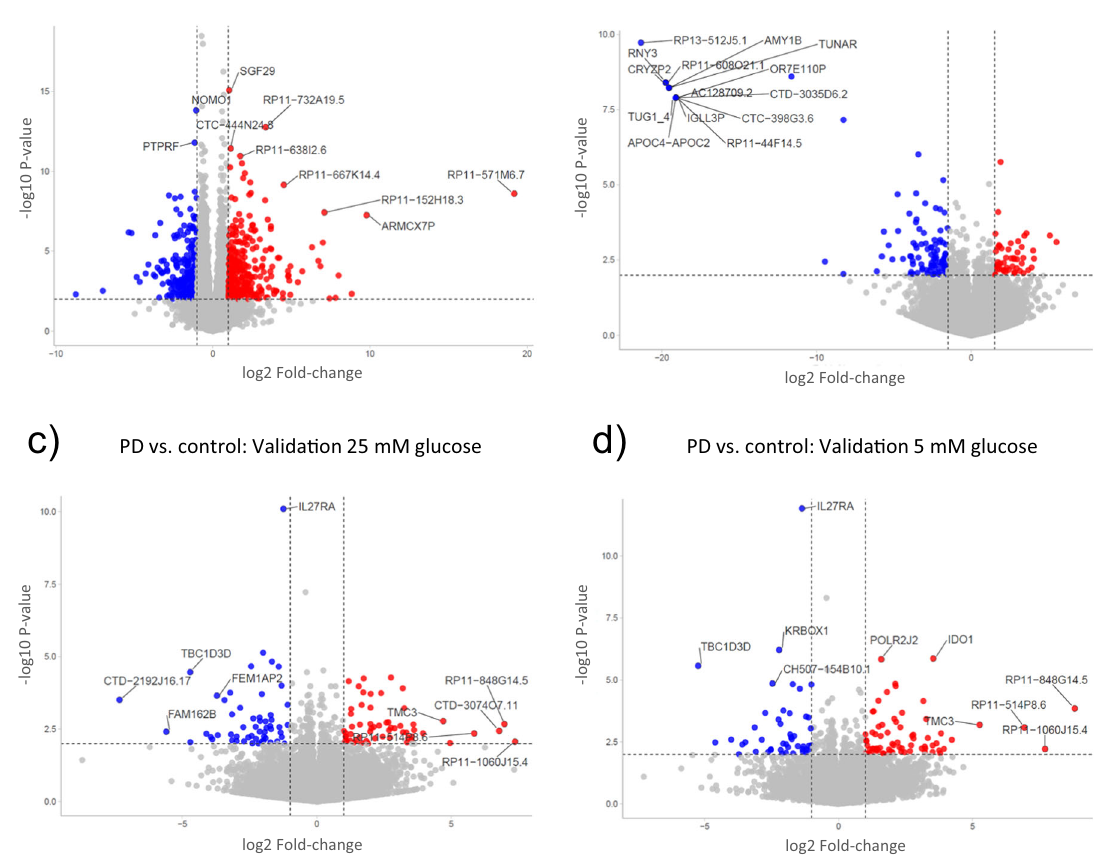
Fig. 1 Volcano plots showing gene expression differences between overall PD and controls across different comparisons. Differentially expressed genes (DEGs) with a P -value <0.05 and a fold-change FC ≥ |2| are depicted in red (up-regulated) and blue (down-regulated). a Discovery cohort at 25 mM glucose. b Discovery cohort at 5 mM glucose. c Validation cohort at 25 mM glucose. d Validation cohort at 5 mM glucose. Volcano plots were done using default settings at the VolcaNoSer software. Annotated dots correspond to the ten DEG data points with the largest (Manhattan) distance from the origin above the signi fi cance thresholds indicated by the dashed line. VolcaNoSer: https:// processes mainly related to the plasmatic membrane, cell adhesion, extracellular matrix, and neuronal processes (Table 1). Despite the higher number of DEGs found in iPD with respect to L2PD which are potentially related to the higher number of iPD studied patients than L2PD, we found very similar affected biological terms in iPD or L2PD compared separately with controls (Supplementary Table 3). In the validation set, the biological enrichment analysis at low and high glucose again revealed biological terms mainly related to the extracellular matrix, cell adhesion, plasma membrane, and synapsis (Table 1 and Supplementary Table 3). Remarkably, despite the limited DEG overlap across all four comparisons (Fig. 1e) we found a highly consistent pathway deregulation (Table 1 and Supple- mentary Table 3).